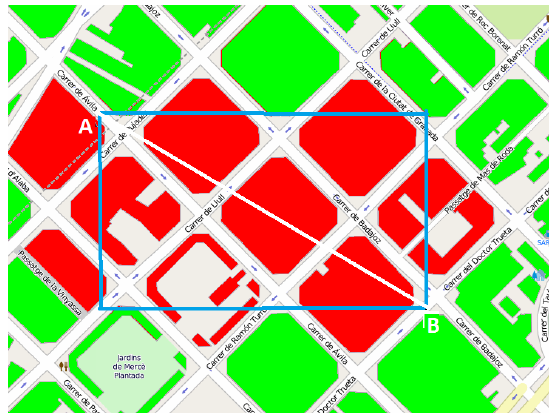
Figure 2. Detection of relevant building influence in the transmission process between nodes A and B. Red buildings are considered to have a relevant influence. We use a zone map of Barcelona,